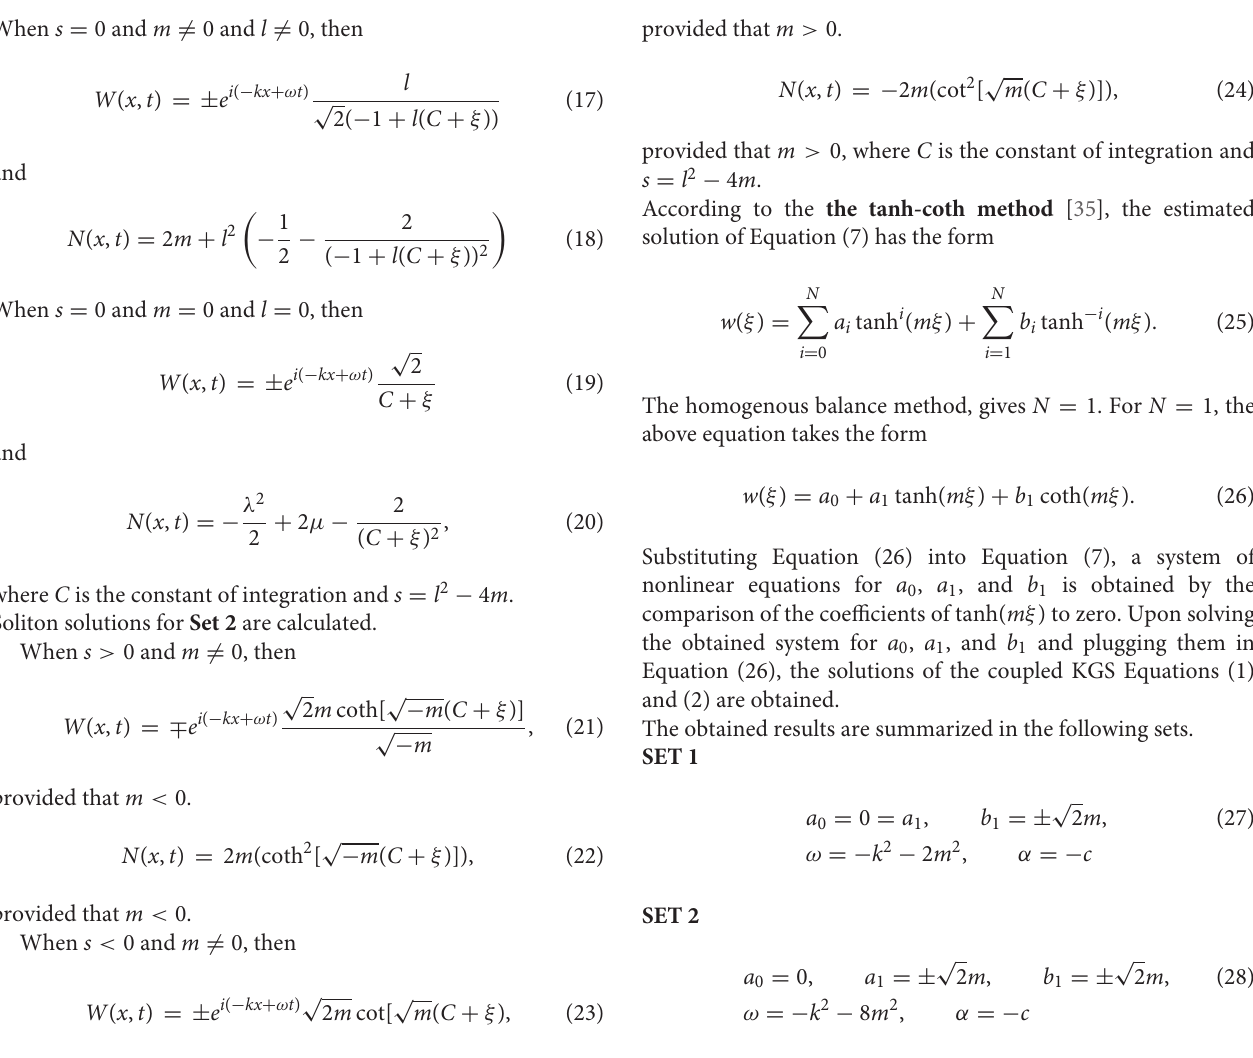
1, s 3, m 1, k 1, ξ x 2t and C = = − = = = +